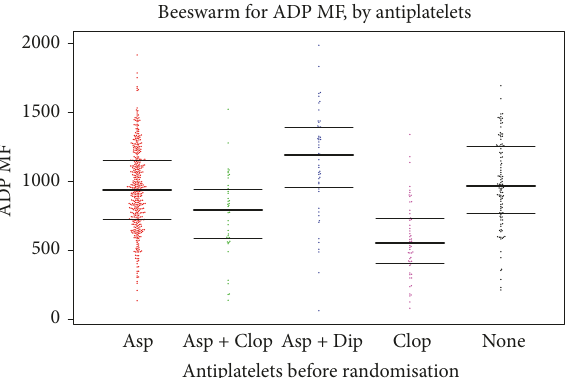
Figure 2: P-selectin in response to adenosine diphosphate (ADP, clopidogrel test), by antiplatelet medication taken prior to randomisation. Data are median fluorescence (MF). The horizontal lines show the median and interquartile